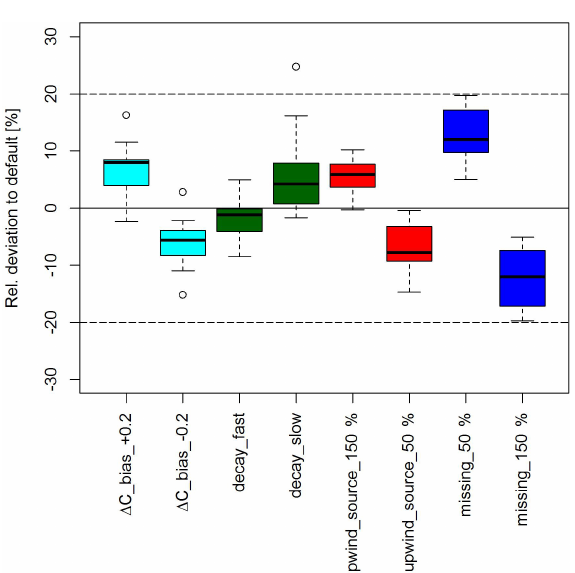
Figure 8. Sensitivity analysis of various error sources on emission results for individual rotations. Each box plot shows the resulting relative effect of a potential systematic error. The investigated ef- fects include the overestimation or underestimation of the offset in concentration measurements (cyan), the exponential decay times of the default emission curves in Fig. 6 (green), and the magnitude of default emission curves used for upwind source interference correc- tion (red) and for gap filling (blue).